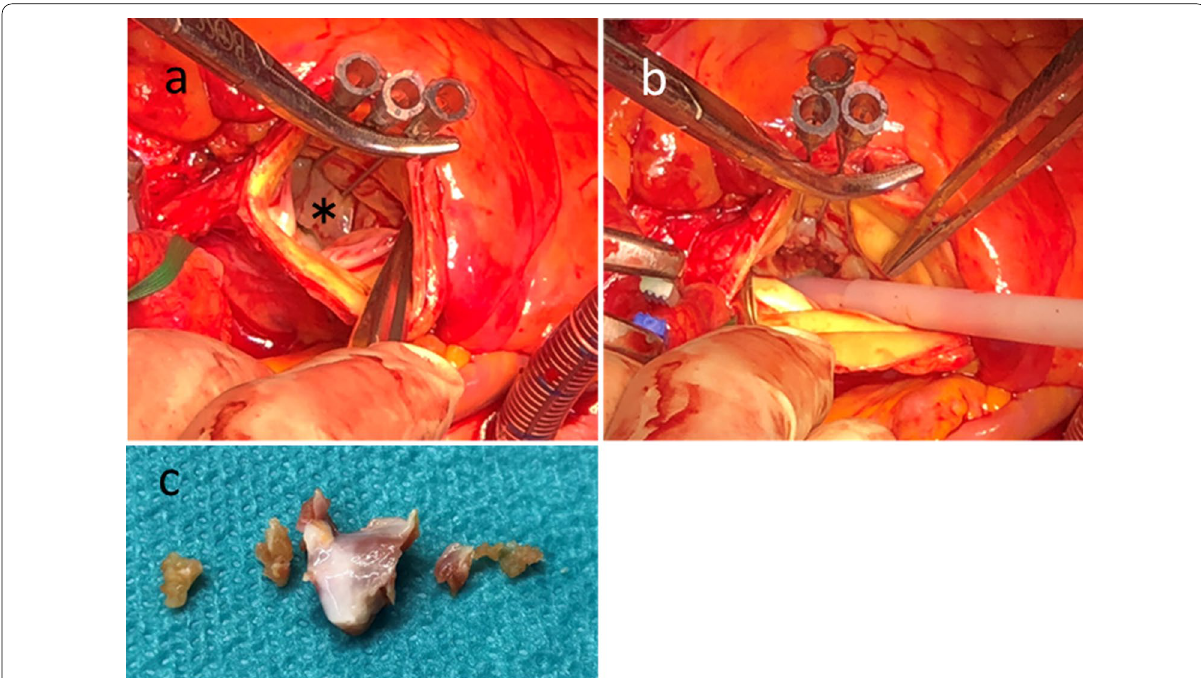
Fig. 3 Needle stick technique of the interventricular septal muscle resection. a Exposure of the part of the interventricular muscle to be resected. Black asterisk indicates the interventricular septal bulge. b Resected part of the interventricular septal muscle. c Resected muscle pieces of 278 mg in